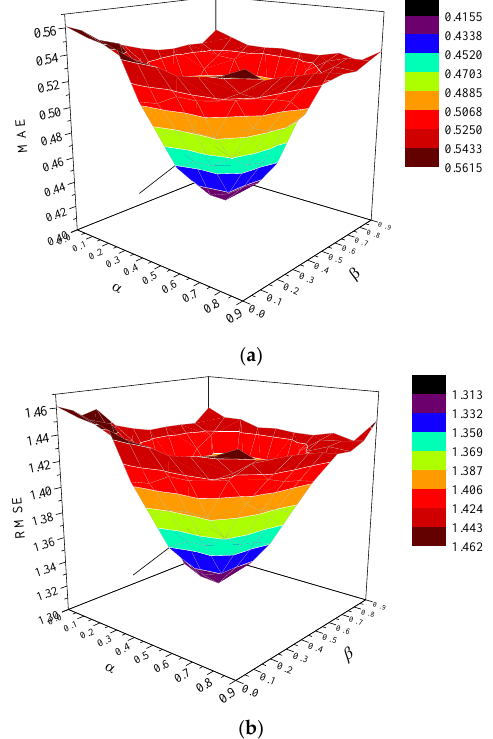
Figure 6. Impact of α and β . ( a ) Impact on MAE; ( b ) Impact on